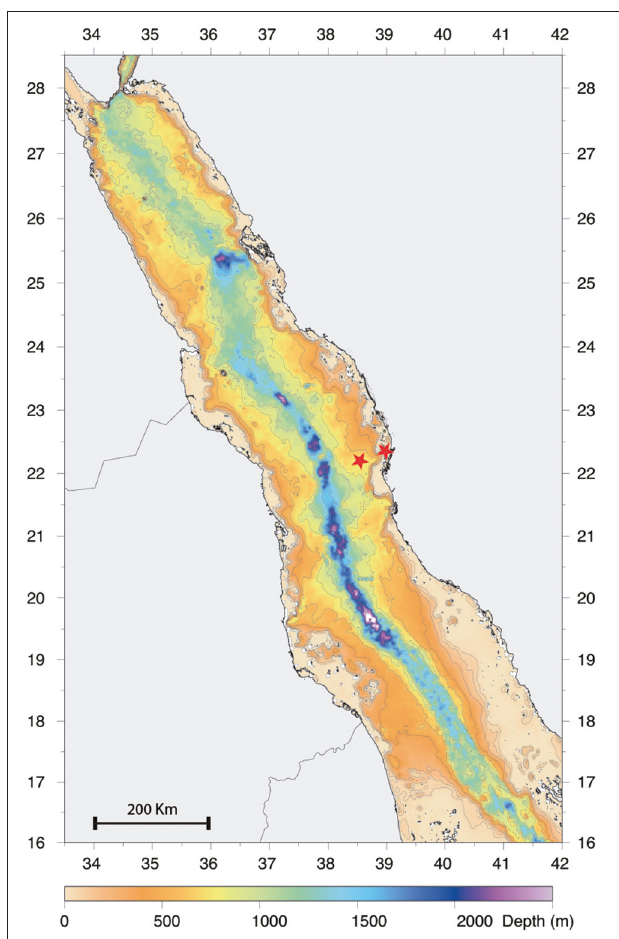
FIGURE 1 | Bathymetry Red Sea map showing the positions of the offshore and inshore sampling stations (highlighted using a red star) and their corresponding